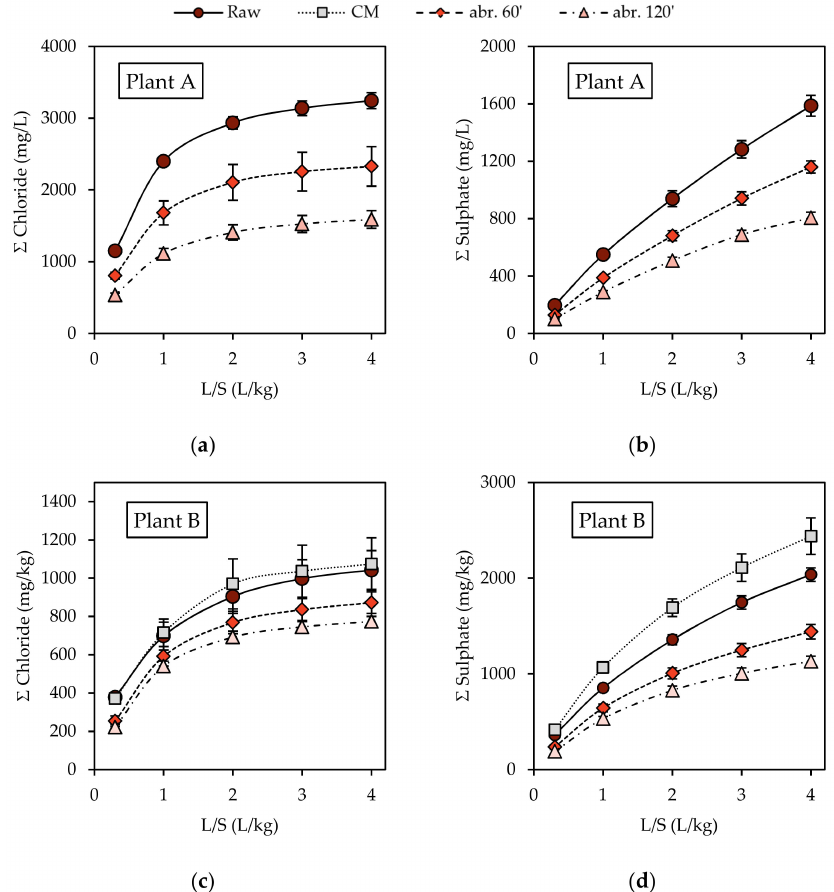
Figure 6. Trends of ( a ) chlorides and ( b ) sulphates’ cumulative release from the raw BA samples, and of ( c ) chlorides and ( d ) sulphates’ cumulative release after the abrasion tests (raw: untreated samples; CM: samples treated in the concrete mixer for 240 min; abr. 60 and abr. 120: samples treated in the sieving drum unit for 60 min and 120